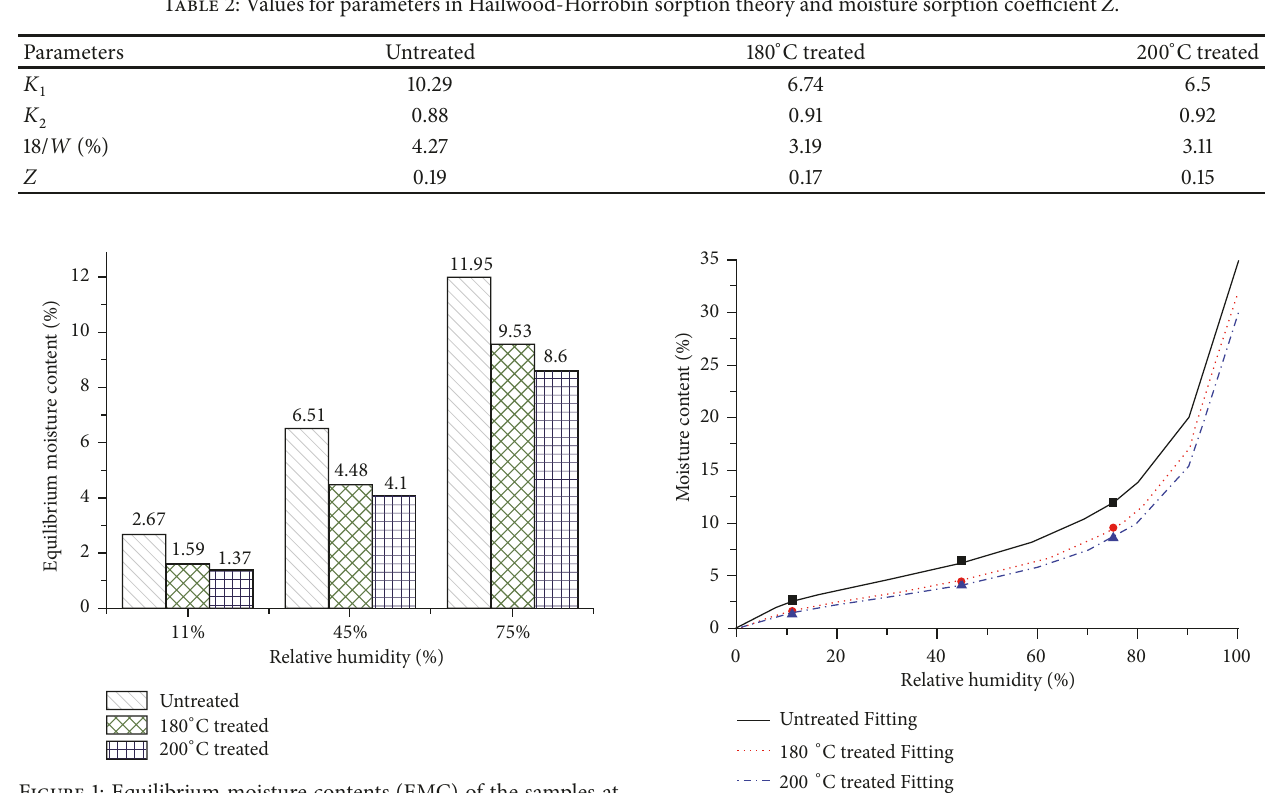
Figure 1: Equilibrium moisture contents (EMC) of the samples at various humidities.